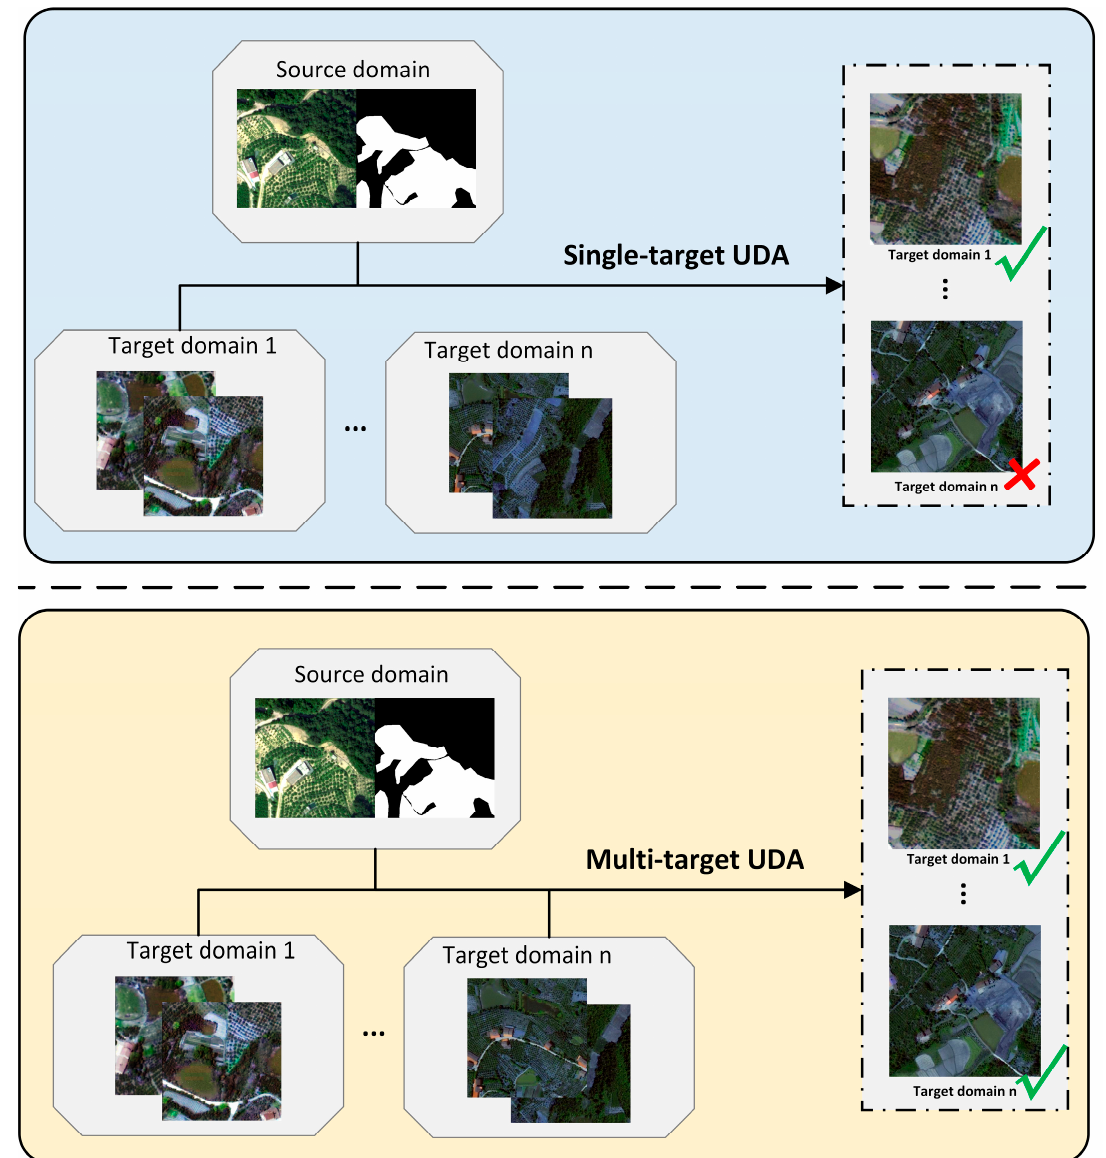
Figure 1. The different unsupervised domain adaptation scenarios in cross multidomain orchard area segmentation.